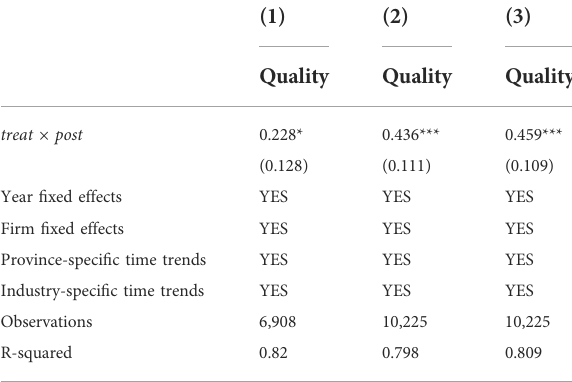
TABLE 4 Eliminating the impact of energy policies and environmental